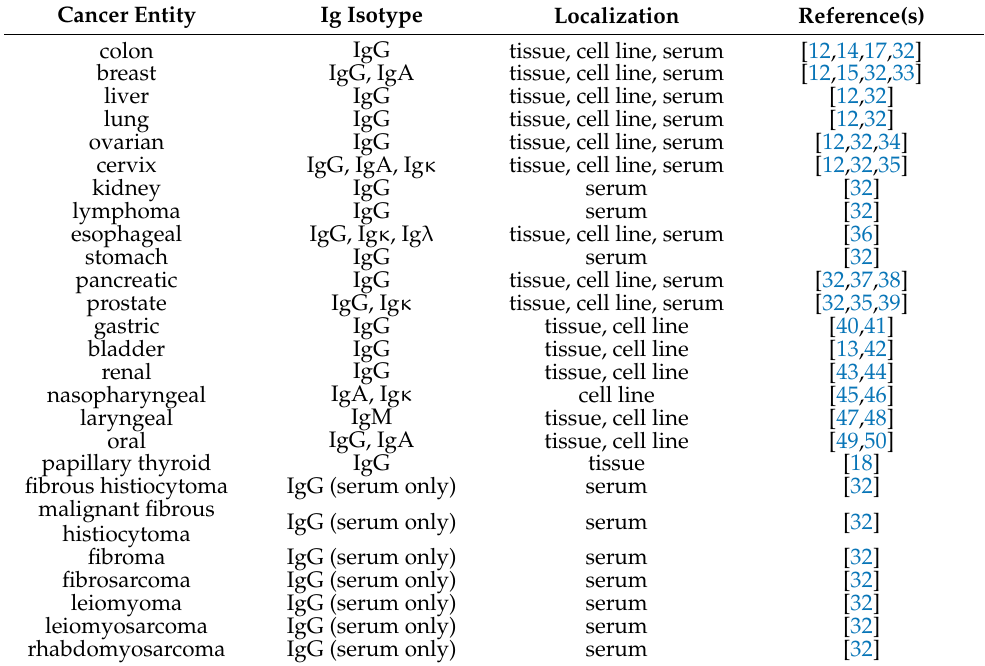
Figure 1. Normal human IgG (green) circulates in the bloodstream of healthy individuals and tumor patients, while CIgG (blue) is only present in the blood of tumor patients. Anti-human IgG antibodies (grey) detect both normal IgG and CIgG, but RP215 (also grey) specifically binds to the Asn162 epitope, solely present on CIgG. IgG: immunoglobulin, CIgG: can- cer-derived IgG. Table 1. Ig isotypes detected in tissues, cell lines and serum samples of different cancer entities.